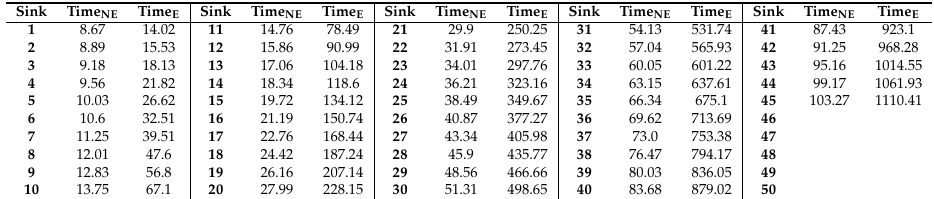
Table A5. Scenario 5: transmission times (in s) for each sink all over the transmission line. (Distance between poles is equal to 50 m, κ = 1, η = 45, NE means no encryption, E means